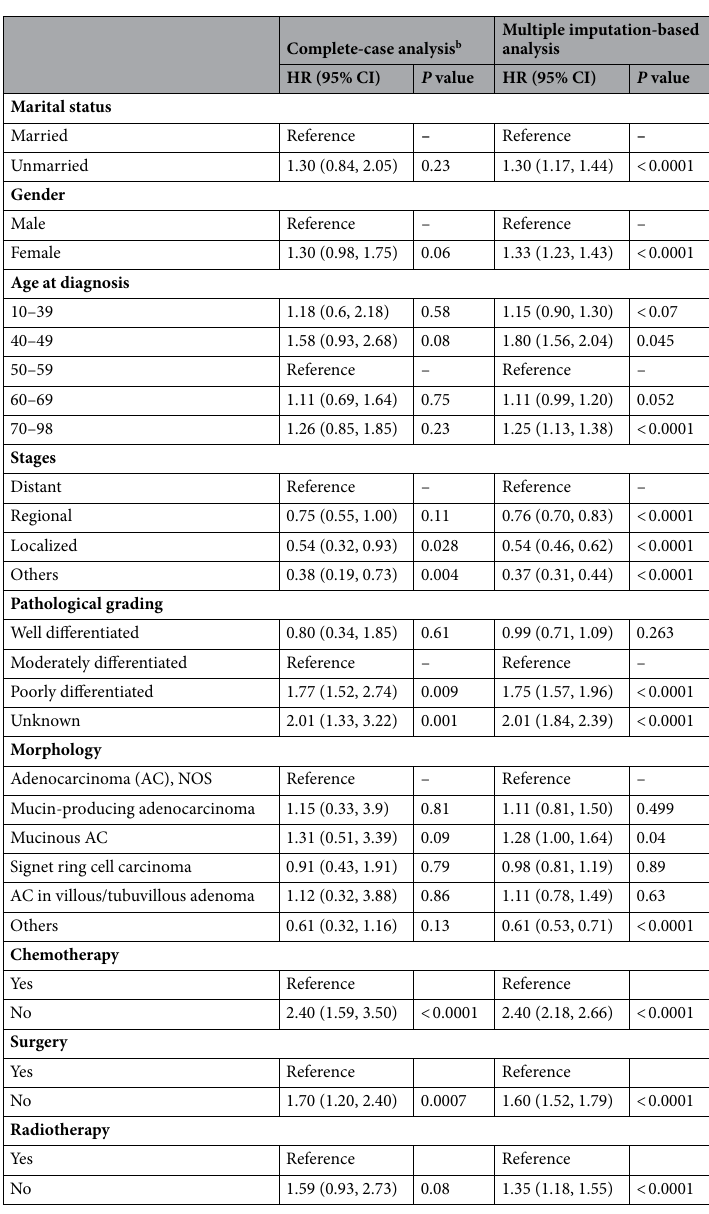
Table 2. Multivariate survival analysis for evaluating the influence of marital status on colorectal cancer over 5 years , MNG-HA, 2009–2017 a . a Data represent Saudi patients registered in MNG-HA hospitals system between January 1 2009 and December 31 2017. b Complete cases including missing